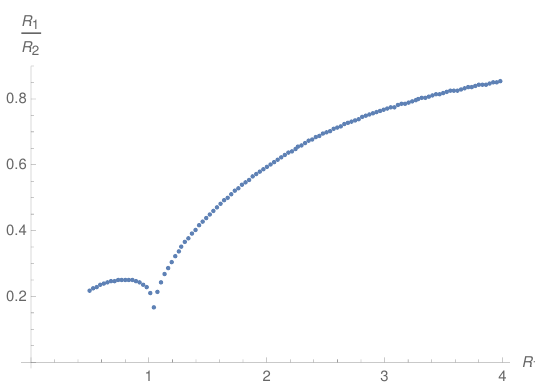
Figure 14 . Relative radius R 1 =R 2 of the system as a function of the inner radius R 1 for a (cid:12)xed chosen mass m 1 = 1 : 5. The largest e(cid:11)ective volume is achieved for con(cid:12)gurations near the boundary between region (i) and (ii) in the notation of (cid:12)gure 9.